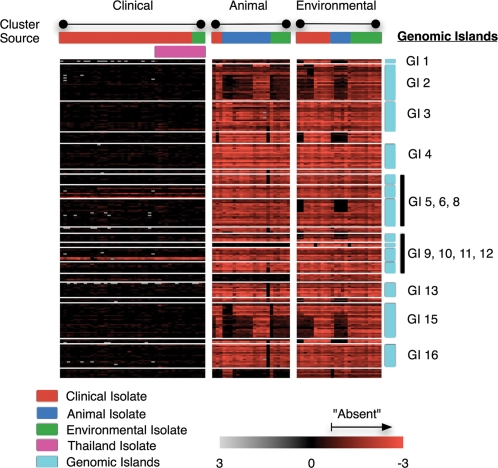
Enrichment of Genomic Islands in Clinical Isolates.Heat map representing absence and presence of GI genes in Clinical, Animal and Environmental isolates. Top row (“Cluster”): AGC clusters corresponding to clinical (left), animal (middle), and environmental (right) isolates. Second row (“Source”) Strains were color-coded according to their original source of isolation, where red = clinical, blue = animal, and green = environmental. Third row: strains highlighted in pink from Thailand. In the heat-map, black indicates gene presence and red indicates gene absence. Locations of the fourteen GIs are depicted on the right.